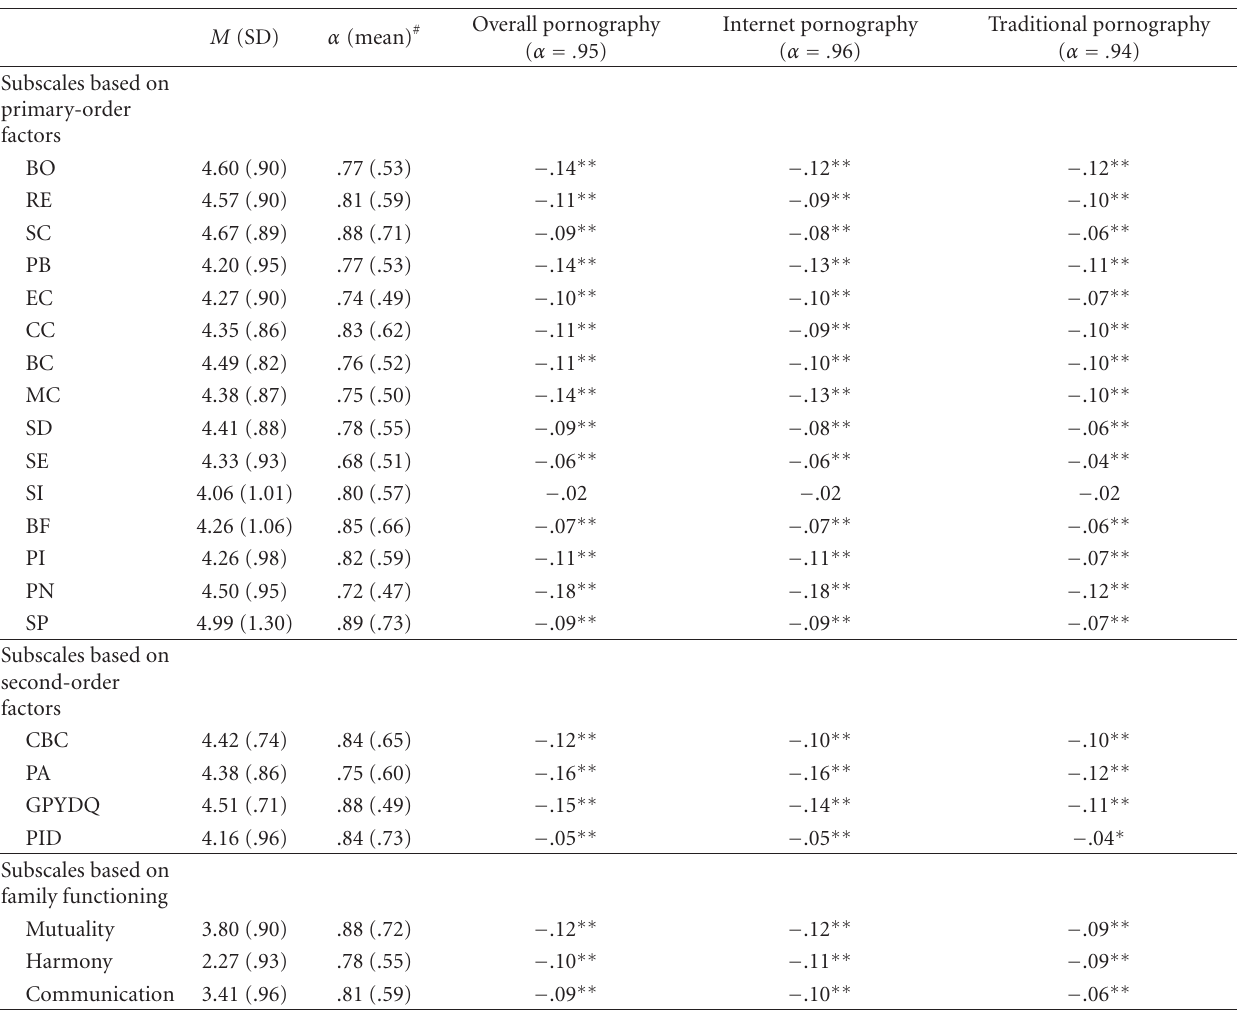
Table 4: Correlations among variables in the